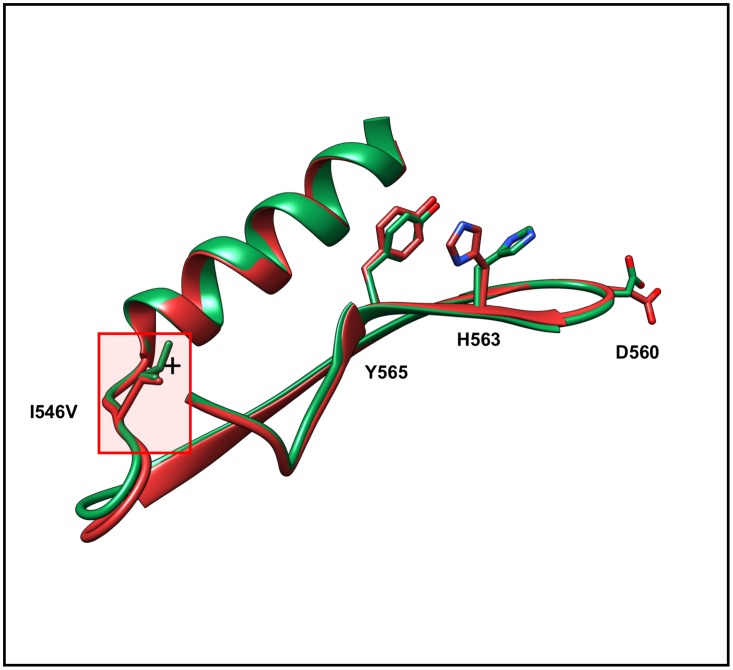
von Willebrand factor (wild-type: green PDBID 1OAK; I546V mutant PDB: 1IJK) with the location of I546V mutation highlighted.Substitution of Ile with Val at position 546 creates a cavity in the hydrophobic core of the I546V mutant structure, which is occupied by a water molecule (denoted by +). The resulting structure perturbation is transmitted through the interior of the protein affecting the locations of the sidechains of Y565, His563, and D560. Collectively, these changes affect Gplb binding, giving rise to von Willebrand’s disease.